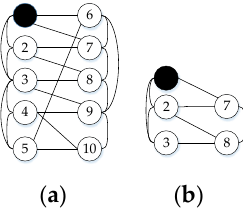
Figure 2. ( a ) is a CPS with 10 nodes and ( b ) is its subgraph.